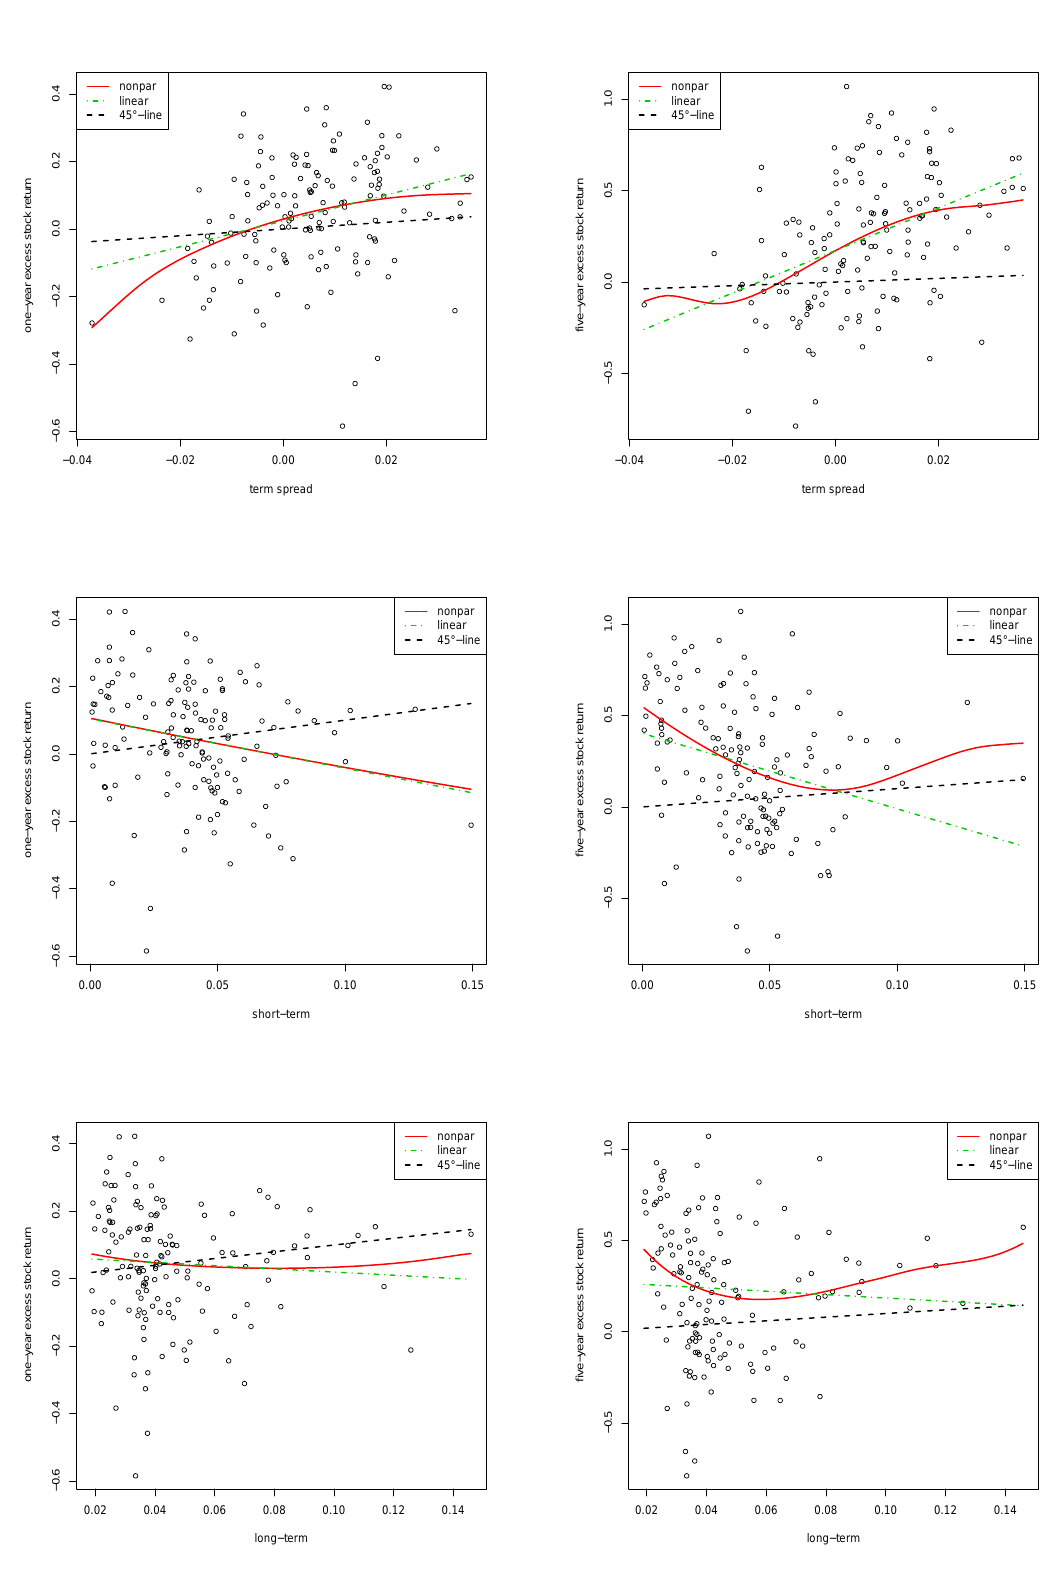
Figure 4. Single risk-free benchmark. Relation between excess stock returns and the spread ( top ), the short-term interest rate ( middle ), and the long-term interest rate ( bottom ). Estimated nonparametric function ˆ m (red solid line), linear model (dash-dotted green line), and 45-degree line (dashed black line). Left : one-year horizon. Right : five-year horizon. Period: 1872–2019. Data: annual S&P